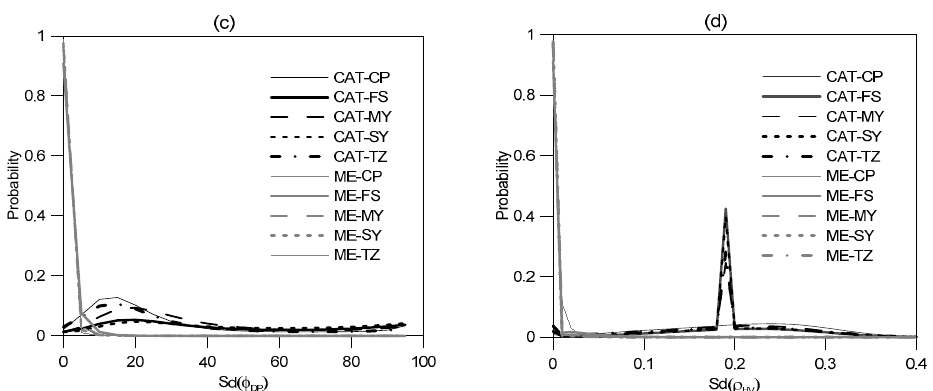
Figure 3. Probability density distribution of parameters ( a ) Sd(Z), and, ( b ) Sd(Z DR ), ( c ) Sd( ρ HV ), and ( d ) Sd( Φ DP ) for ME and CAT.